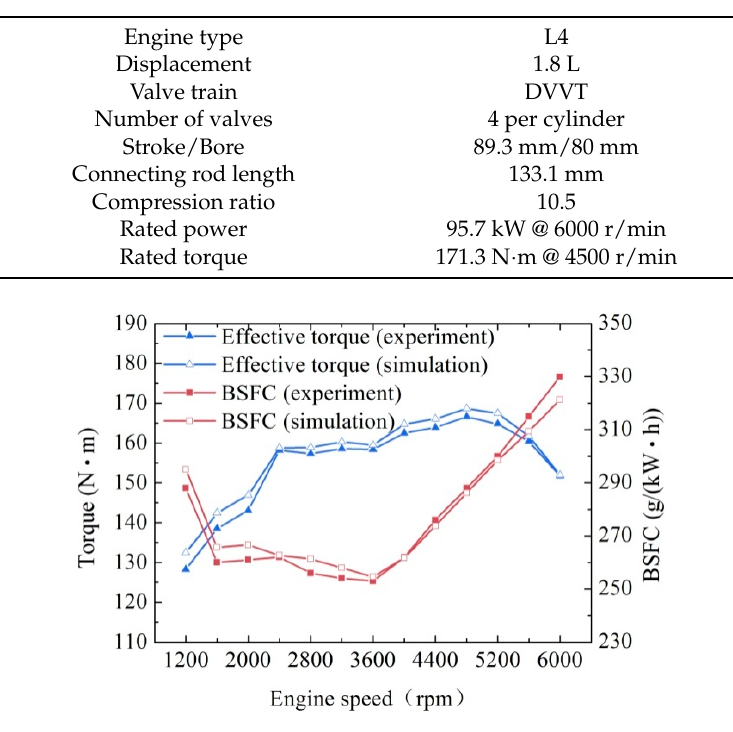
Table 1. Engine specifications.